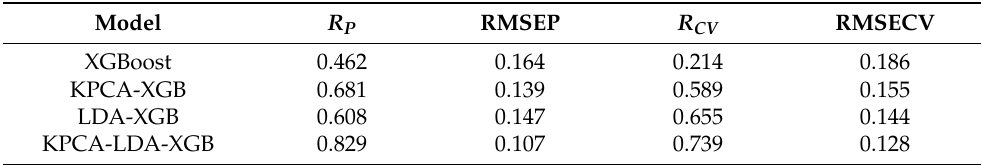
Figure 8. Comparison of the prediction results of the KPCA-LDA-XGB model and the traditional integrated models. ( a ) Prediction results of the XGBoost model ( b ) Prediction results of the KPCA-XGB model. ( c ) Prediction results of the LDA-XGB model. ( d ) Prediction results of the KPCA-LDA-XGB model. Table 5. Comparison of the prediction and cross validation performance of the KPCA-LDA-XGB model and the traditional integrated models.